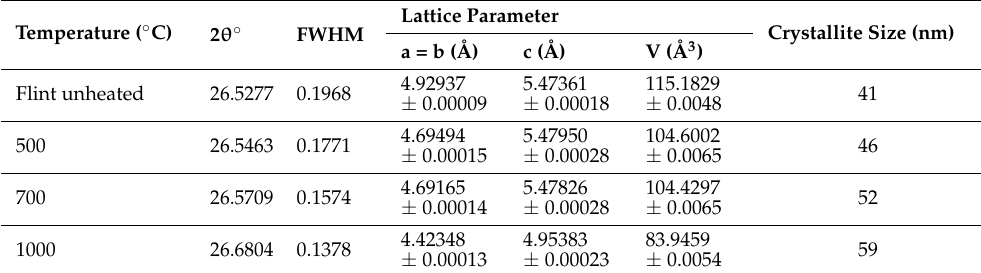
Table 2. The structure parameters of SiO 2 flint heated at 500, 700, and 1000 °C.